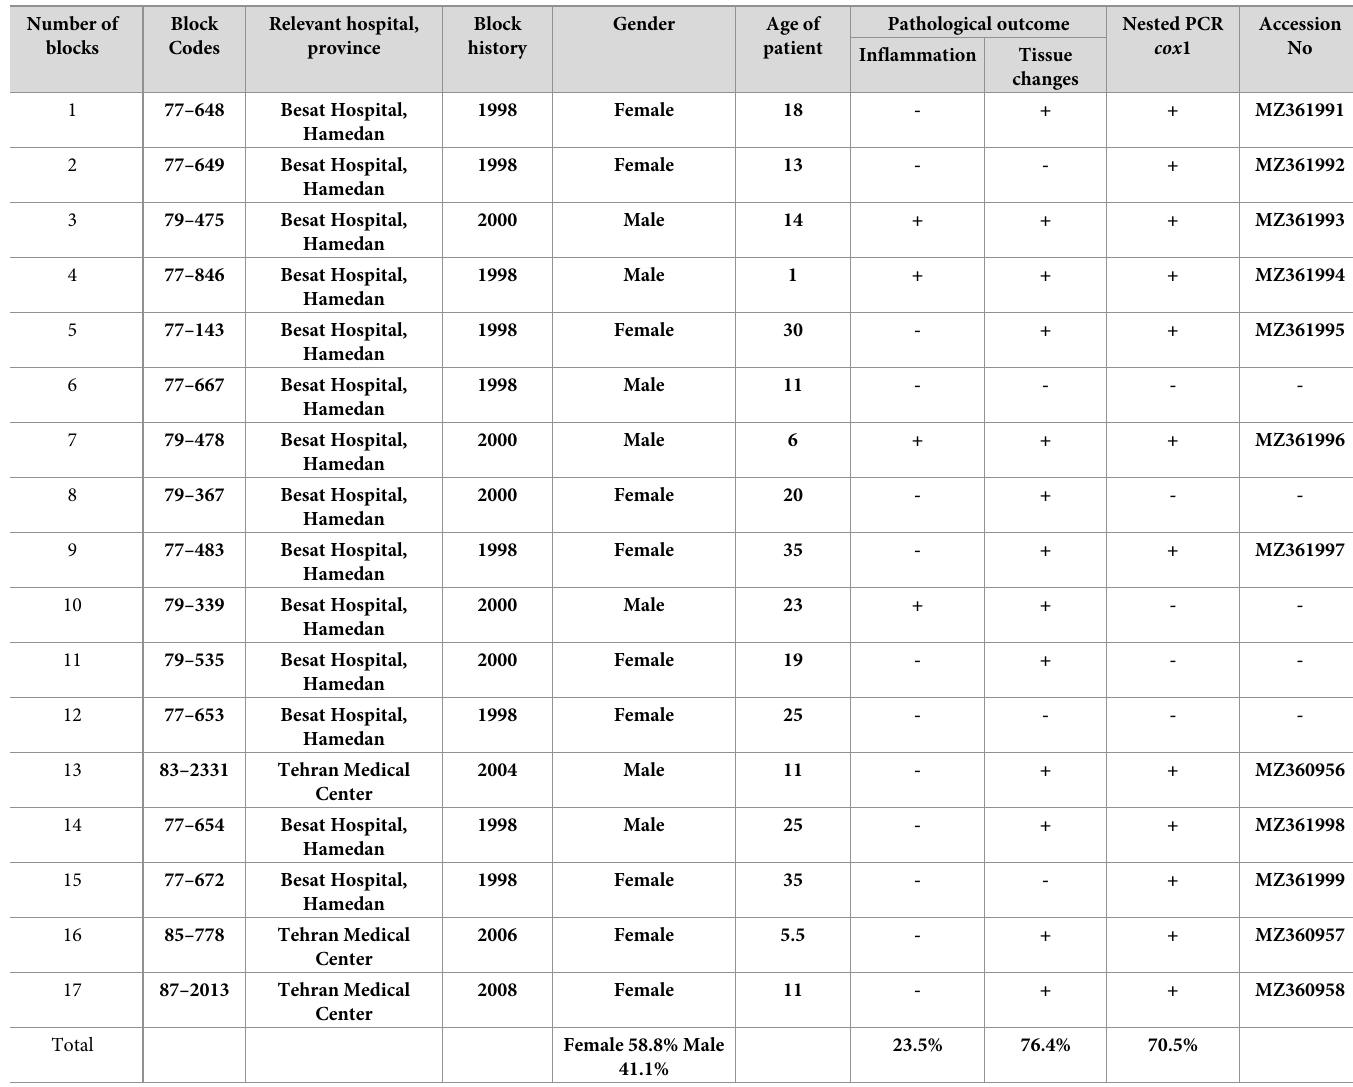
Table 1. Description of appendectomy sections based on age, pathological, and molecular results. Number of Block blocks